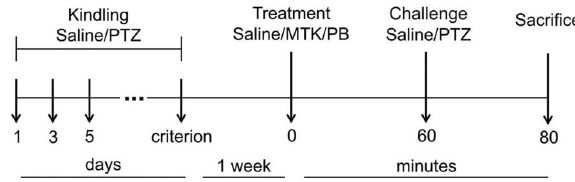
Figure 2. Experimental protocol. Animals were injected with pentylenetetrazol (PTZ) (35 mg/kg, ip ) on days 1, 3, 5, 8, 10, 12, 15, 17, 19, 22, 24, 26, 29, 31, and 33 until a speci fi c criterion was met. Each kindled mouse was matched with a saline-treated animal. One week after kindling induction, mice were treated with saline, MTK (10 mg/kg, ip ) or PB (20 mg/kg, ip ), 60 min before challenge with PTZ (35 mg/kg, ip ) or saline ( ip ). Animals were observed for 20 min and sacri fi ced. PTZ: pentylenetetrazol; MTK: montelukast; PB: phenobarbital.